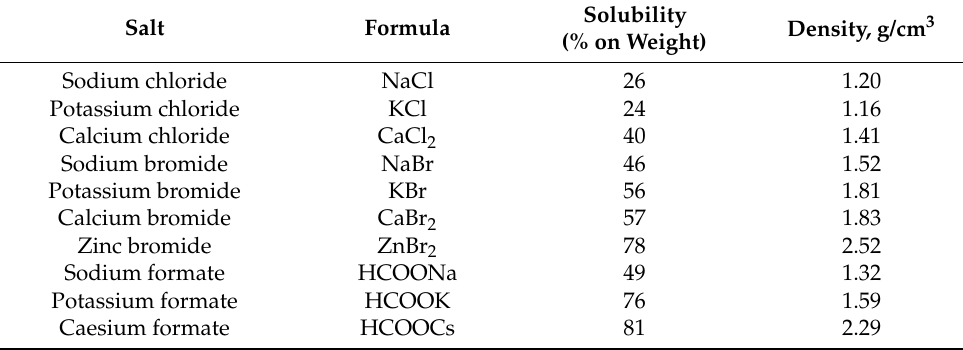
Table 1. Maximum solubility of salts at room temperature